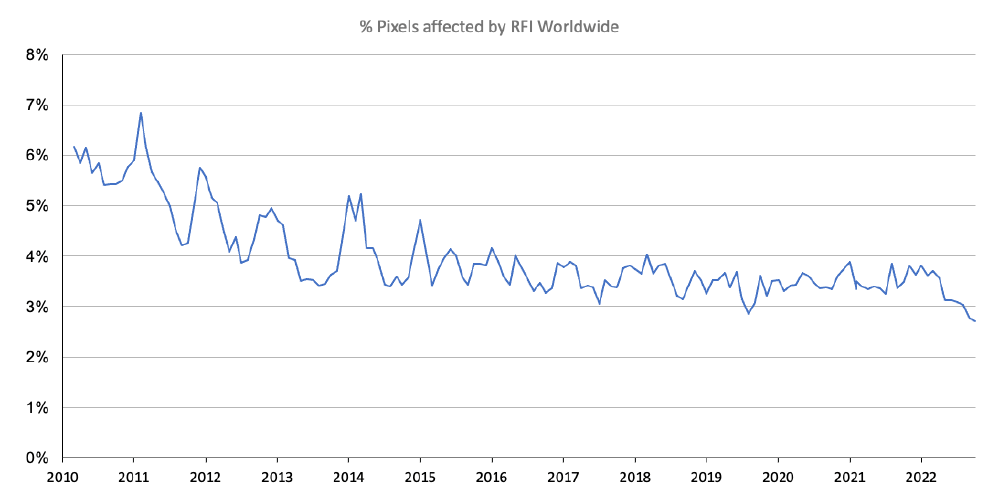
Figure 22. Percentage of pixels affected by RFI in SMOS land products worldwide over the life of the mission.